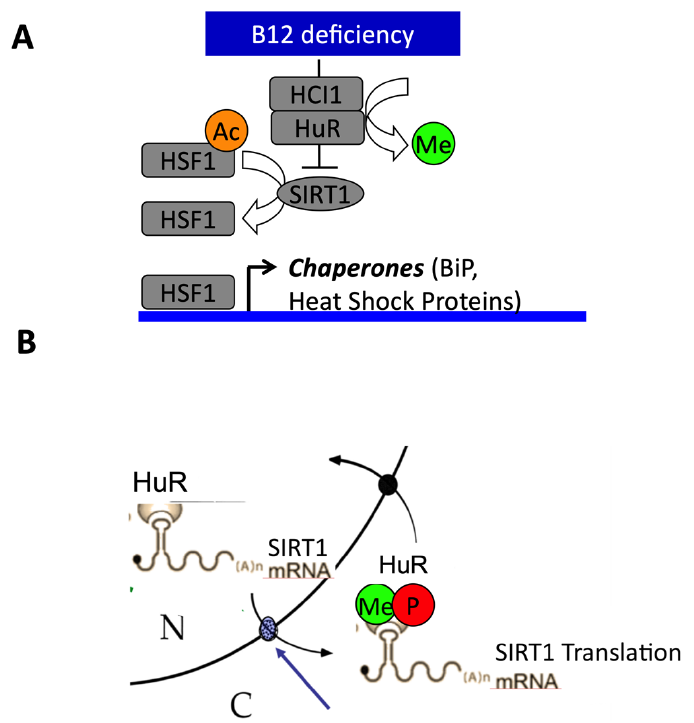
Figure 4. Influence of vitamin B12 cellular availability on endoplasmic reticulum (ER) stress-related decreased expression of Sirtuin1 (Sirt1). ( A ) The decreased cellular availability in B12 activates ER stress pathways and decreases the expression of heat shock proteins through decreased expression of Sirt1 and subsequent hyperacetylation of heat shock factor 1 (HSF1). ( B ) The decreased cellular availability in B12 produces the subcellular mislocalization of the ELAVL1 / HuR RNA binding protein implicated in response to ER stress through hypomethylation by decreased synthesis of methyl S-adenosyl methionine (SAM) and dephosphorylation by increased protein phosphatase PP2A. The blue arrow shows the nuclear pore complex. The mislocalization of ELAVL1 / HuR triggered the decreased expression of Sirt1 by altered Sirt1 mRNA export from nucleus to